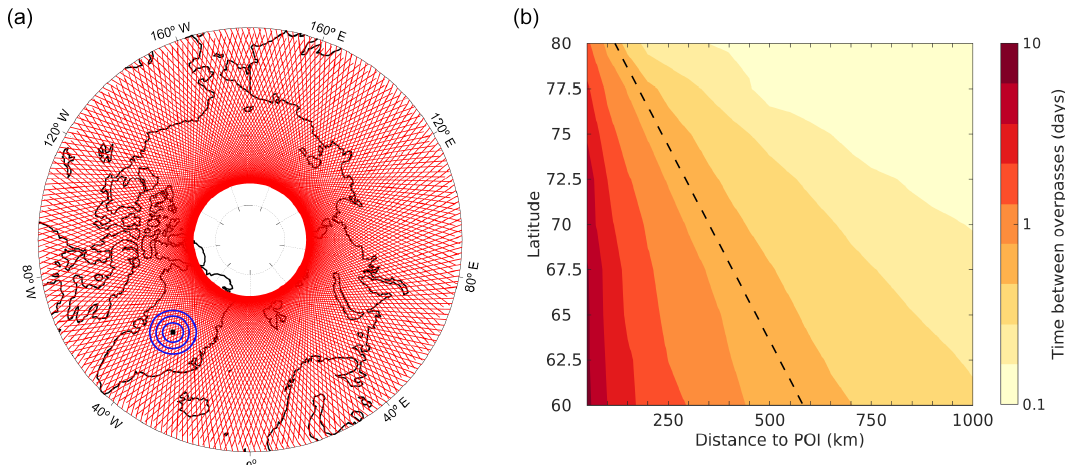
Figure 3. (a) CloudSat and CALIPSO overpass tracks in the Arctic for one repeat cycle of 16 days. The blue circles show the increased sampling rate when a larger area is taken into account. (b) Maximum CloudSat and CALIPSO sampling frequency in function of both distance to the POI and latitude. The black dashed line corresponds to an approximately daily frequency. It should be noted that this is the theoretical maximum sampling frequency at each location. If satellite samples are excluded in processing steps, the real sampling frequency decreases.